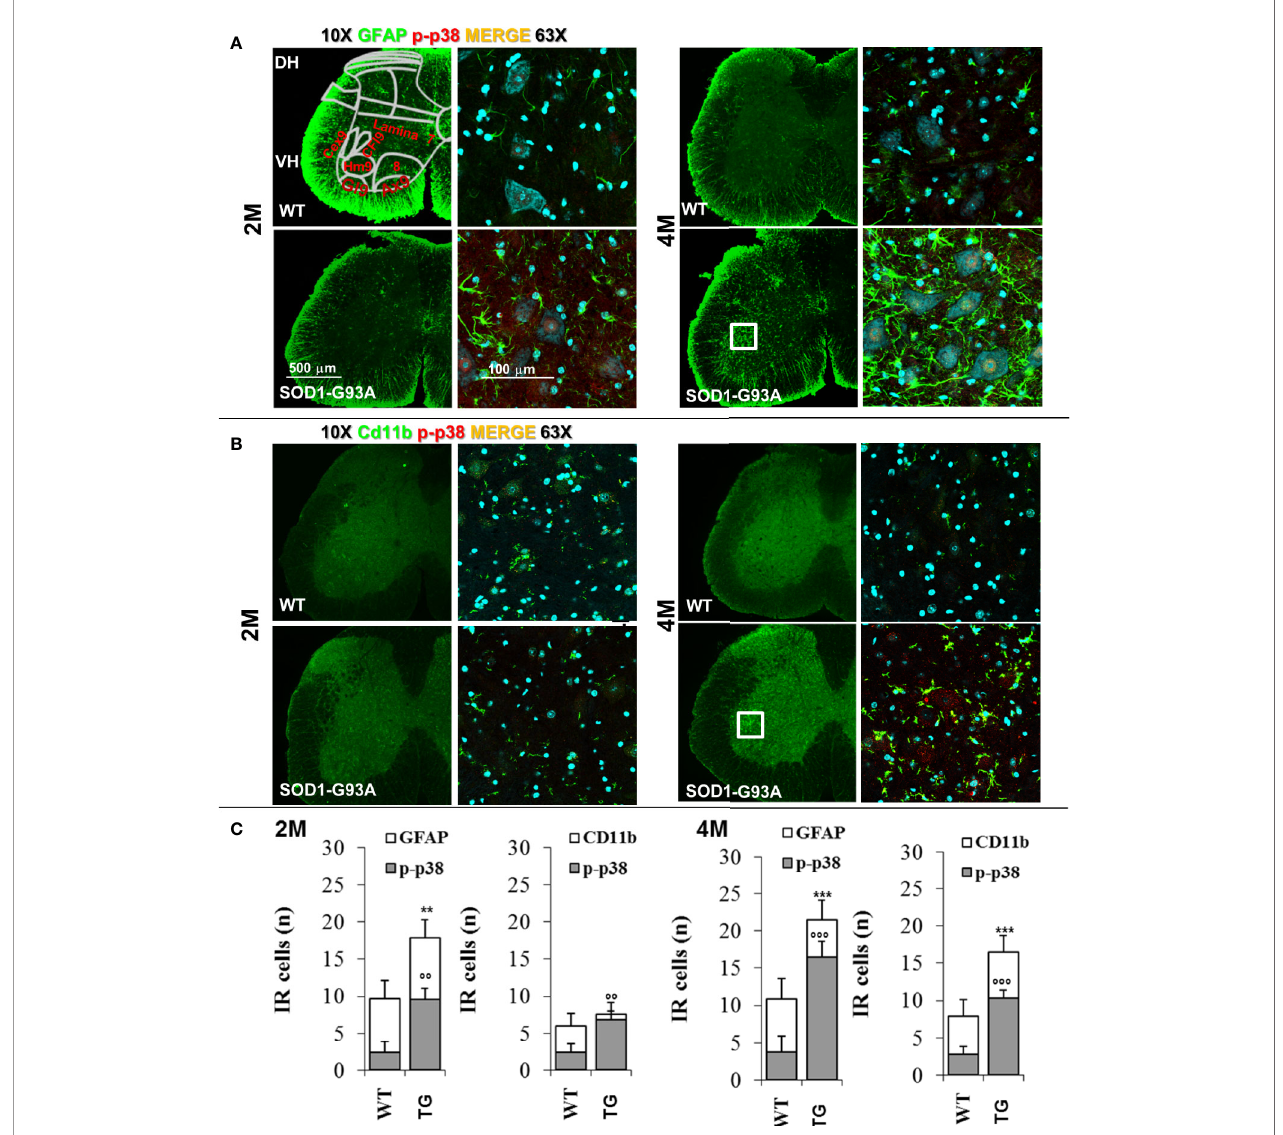
FIGURE 7 | Glia activation in SOD1-G93A+ mice. (A) Representative examples of confocal images of spinal astrocytes (GFAP – green) and their activation (colocalization with p-p38 – red) in lumbar sections (magni fi cation 10x and 63x) of 2M and 4M WT and SOD1-G93A+ mice and (B) microglia (Cd11b – green) activation (p-p38 – red). Schematic representation of ventral laminae (VH – ventral horn, lamina 9: Cex9 – crual extensor, CFl9 – crural fl exor, Hm9 - harmistring, Gl9 – gluteal muscle, Ax9 – axial muscle, 8 – lamina 8) is shown in fi rst panel. (C) Immune-responsive cell number for GFAP and Cd11b colocalizion for